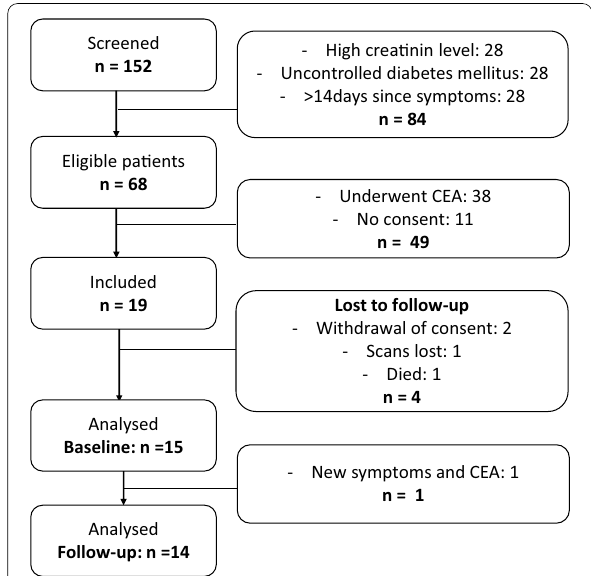
Fig. 2 Flowchart of the included patients. Of the 19 included four were excluded. Two were excluded after withdrawal of consent, one died because of an, at the time of inclusion, undiagnosed cancer and one scan was